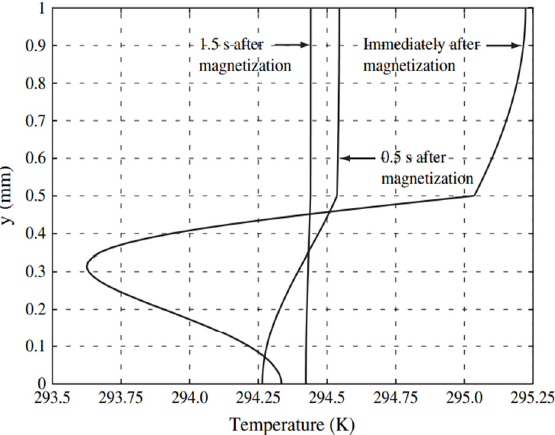
Figure 29. Temperature distribution through the regenerator versus the time after the magnetiza- tion [57].